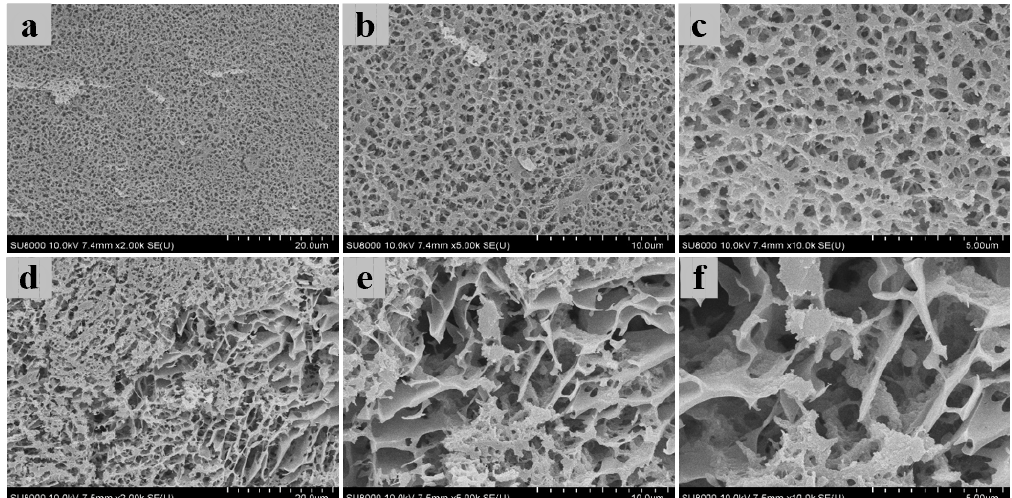
Figure 4. Cryo-SEM images of Antarctic krill and Pacific white shrimp surimi gels: ( a ) PWSS (2000×), ( b ) PWSS (5000×), ( c ) PWSS (10,000×), ( d ) AKS (2000×), ( e ) AKS (5000×), and ( f ) AKS (10,000×). PWSS, Pacific white shrimp surimi; and AKS, Antarctic krill surimi.